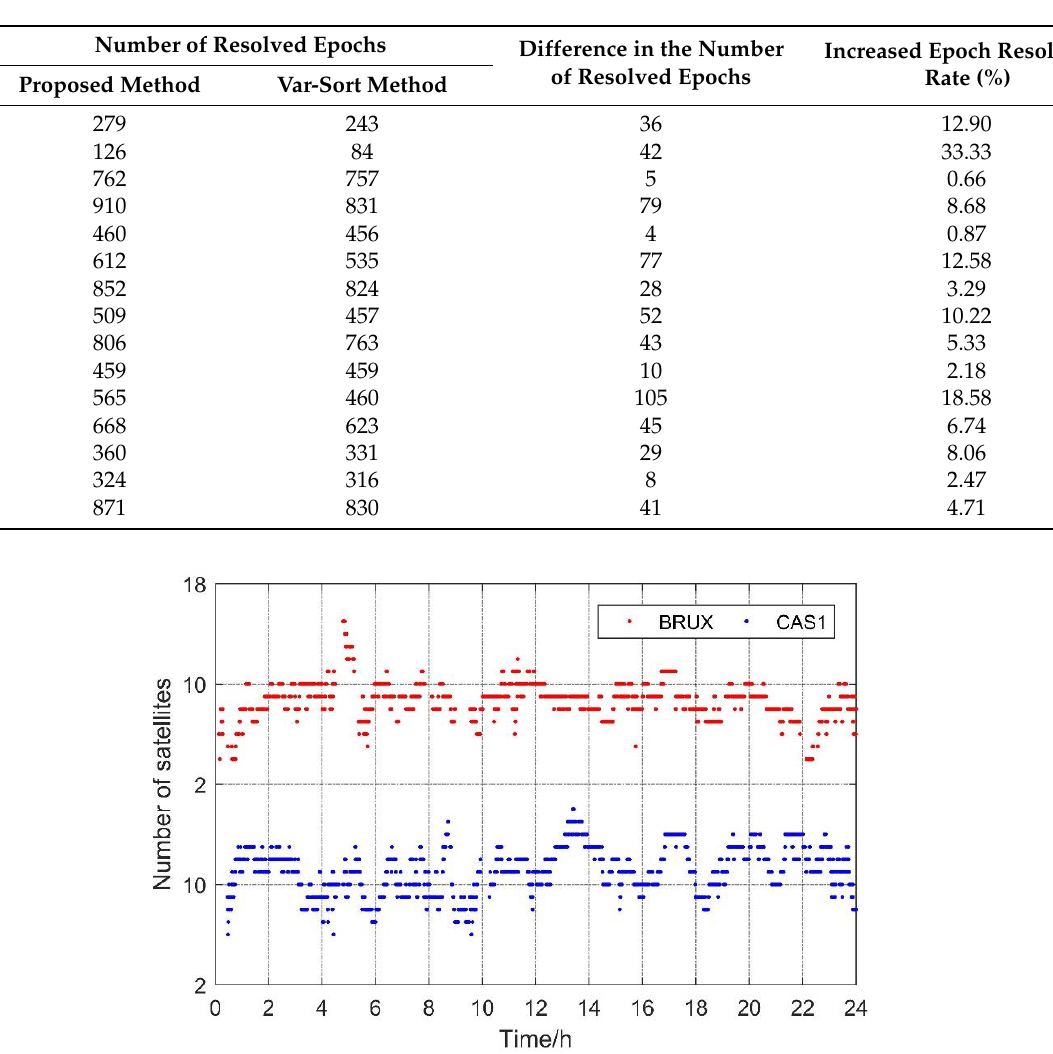
Table 2. Number of epochs of partial ambiguity resolution for each station under two optimal subset selection schemes.